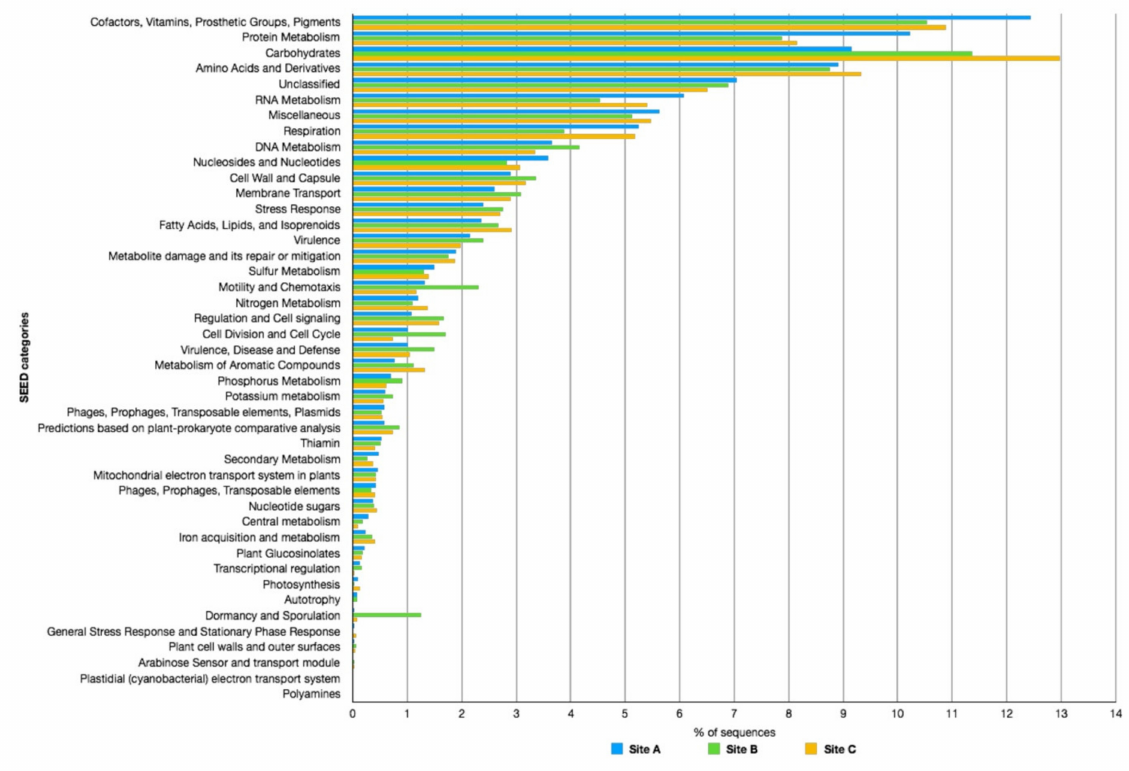
Figure 7. Functional annotation according to the SEED database of the metagenomes in Pisciarelli sites A, B, and